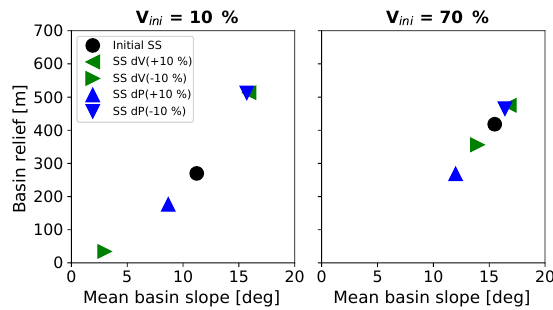
Figure 14. Shifts in the mean basin slope–mean basin relief rela- tionship for simulations with positive and negative step changes in either vegetation cover (green triangles) or mean annual precipita- tion (blue triangles). Black dots represent initial steady-state con- ditions prior to any imposed transient in vegetation cover or mean annual precipitation. Note that the sensitivity of topographic relief to perturbations in precipitation or vegetation cover is highest for low vegetation cover (10%)